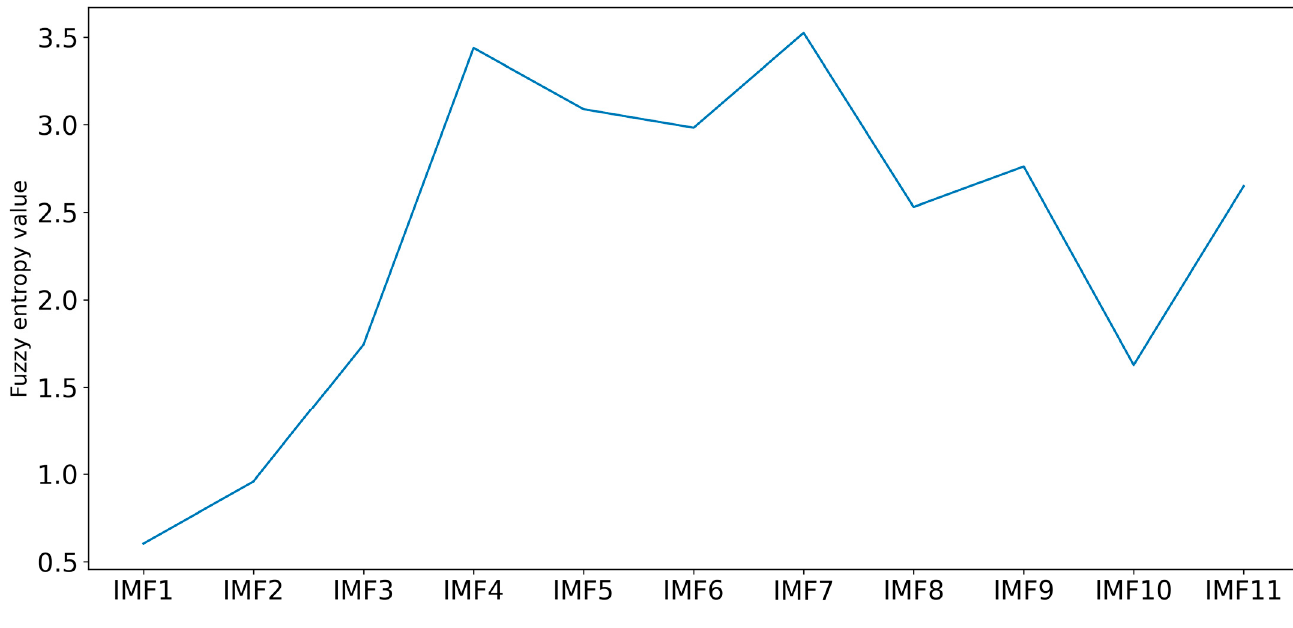
Figure 14. Fuzzy entropy of each IMF. Table 4. FE-IMF composition.